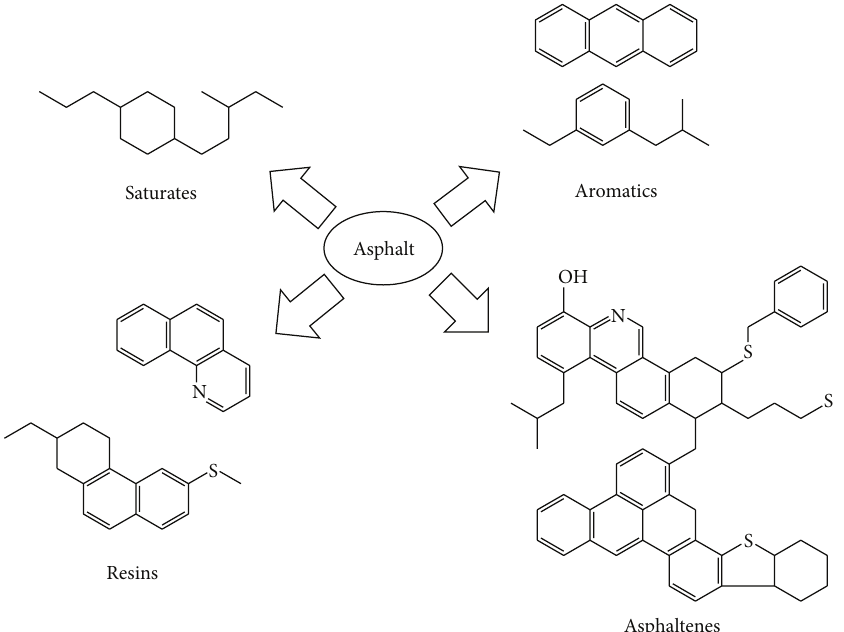
Figure 9: Schematic molecular formulas of four fractions in